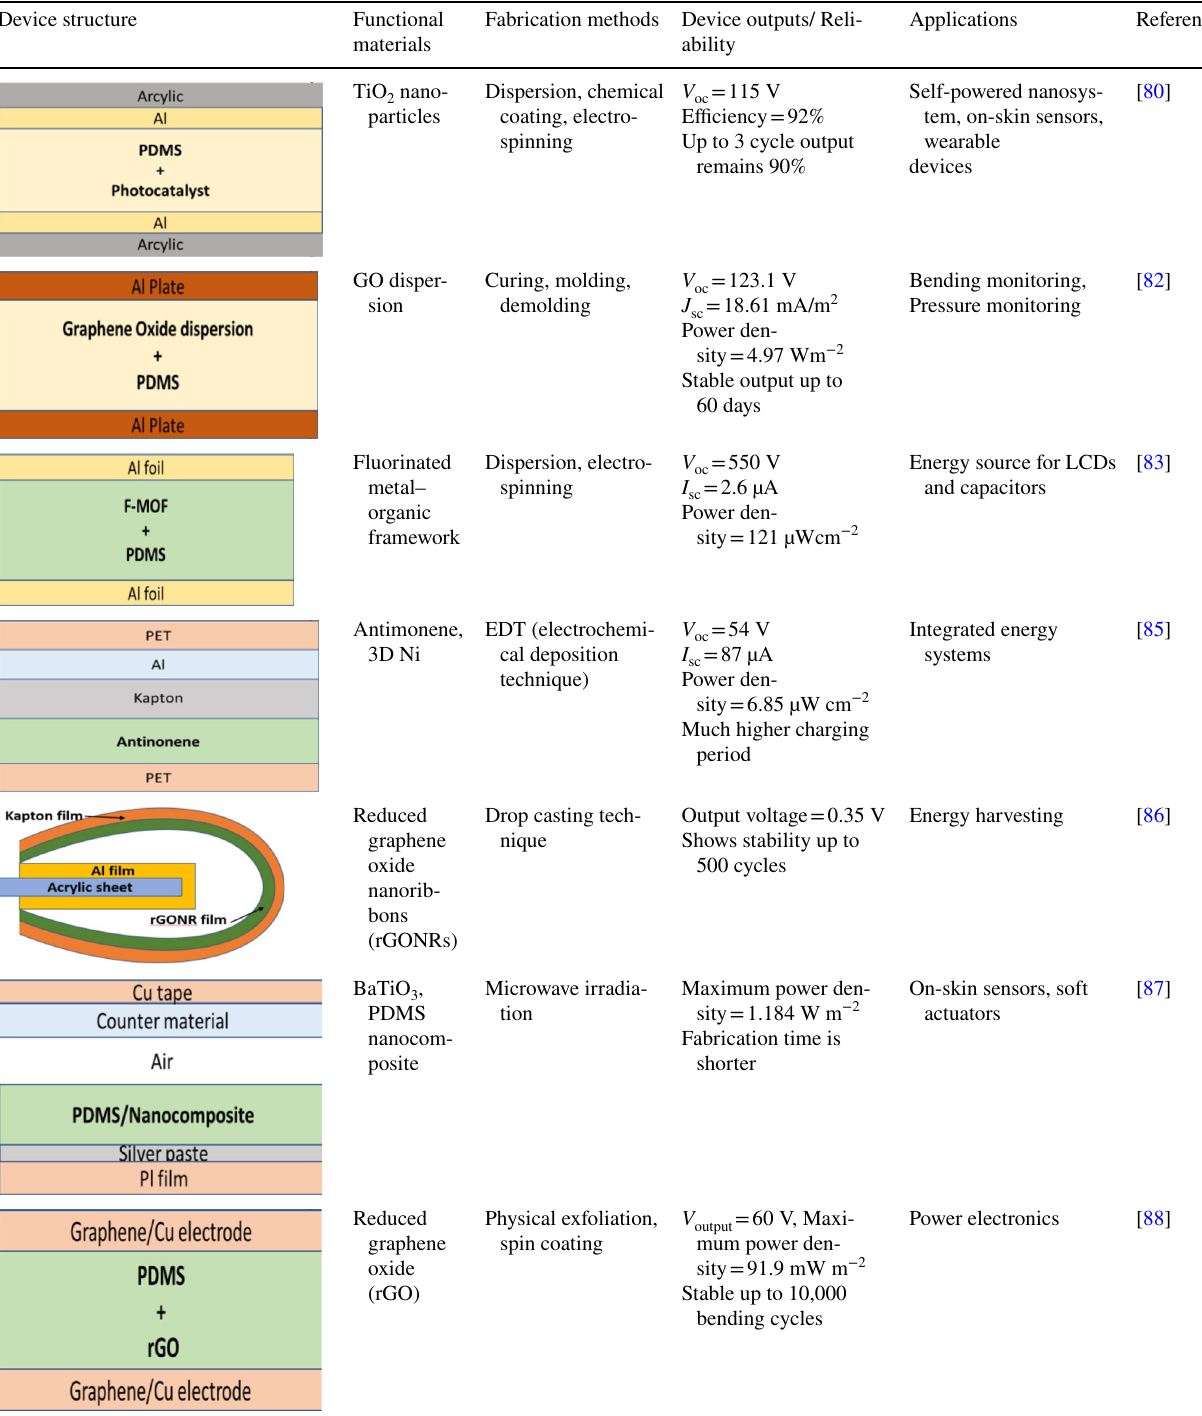
Table 2 Comparative summary of reported work on triboelectric energy harvesting including device structure, functional materials, fabrication techniques, device outputs, reliability, and applications Device